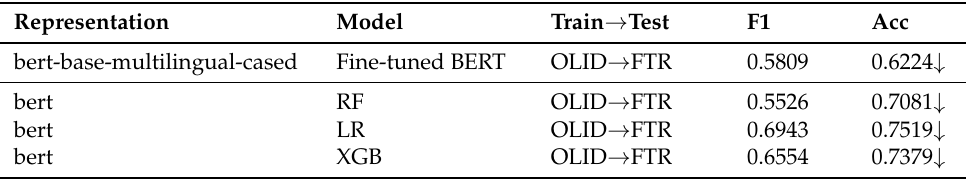
Table 9. Cross-lingual evaluation results (accuracy and